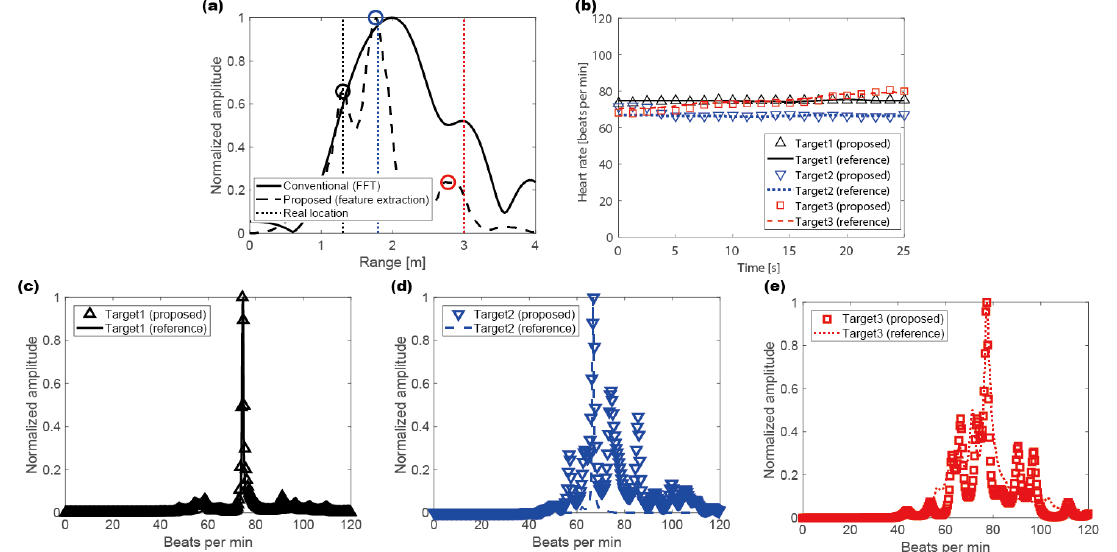
Figure 13. Measurement results for three targets: ( a ) range estimation for three targets at distances of 130, 180 and 300 cm; ( b ) comparison between the proposed method and the reference sensor in terms of the real-time data; ( c ) heart rate for target 1 in terms of total time; ( d ) heart rate for target 2 in terms of total time; and ( e ) heart rate for target 3 in terms of total